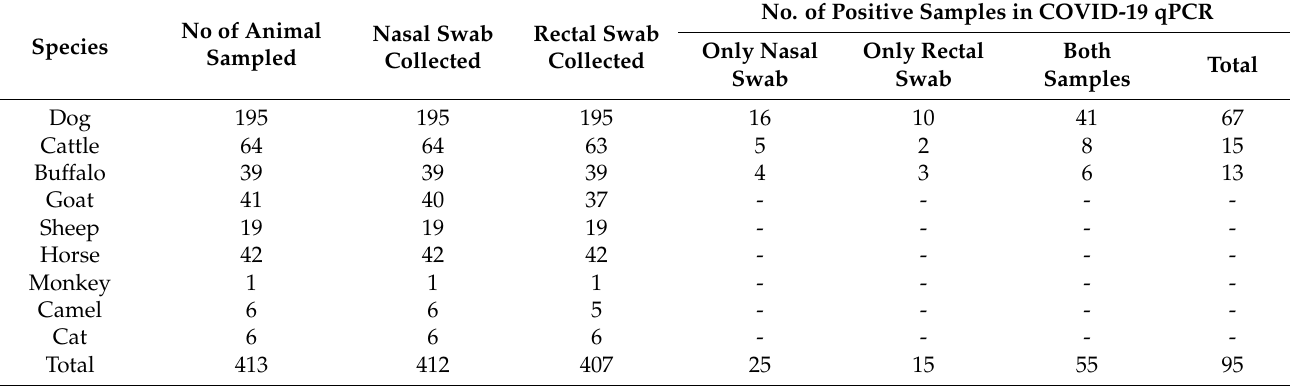
Table 2. Results of the COVID-19 qPCR, according to species and